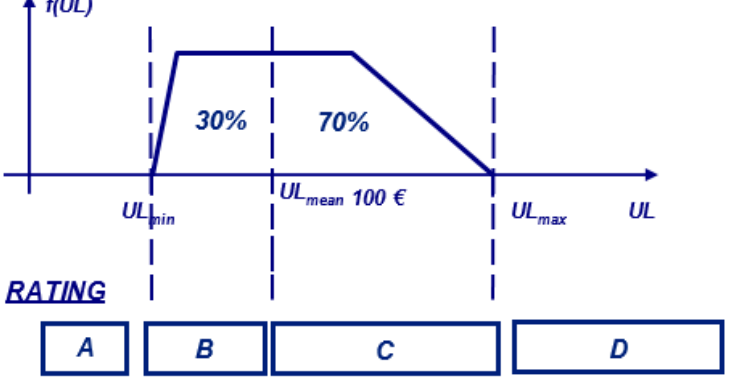
Figure 9. Example of UL density function and rating classes. Source: author own study.